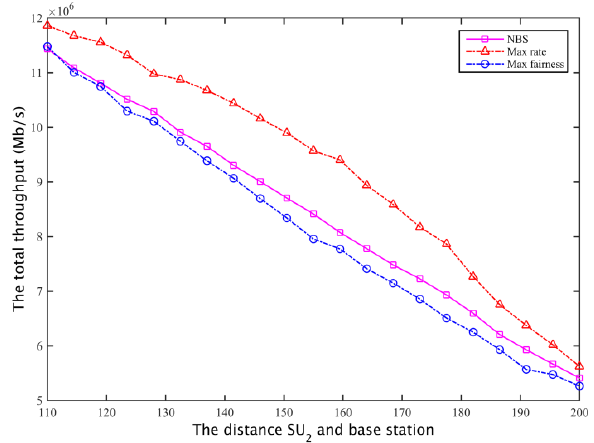
Figure 22. The comparison of total throughput for the secondary network I.